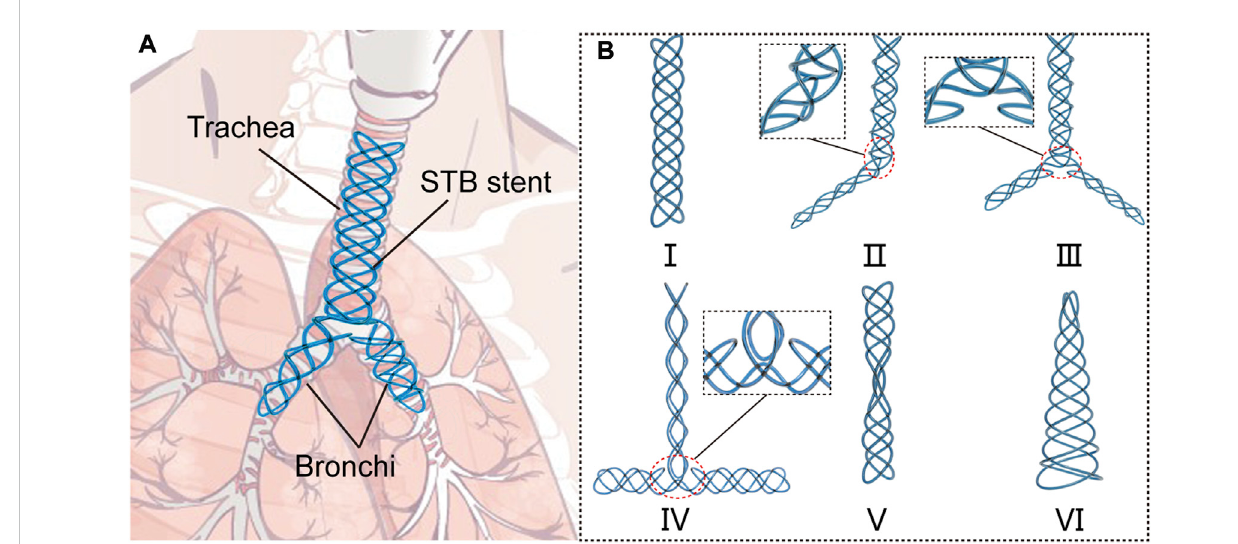
FIGURE 1 Concept of the single-tube-braided airway stent. (A) A schematic diagram, in which a Y-type single-tube-braided (STB) stent is implanted into the trachea and bronchi. (B) 6 types of STB stents for various airway structures: Type Ⅰ stent, a straight stent for central airway obstruction. Type Ⅱ stent, a L-shape stent to support trachea and one main bronchus. Type Ⅲ stent, a Y-shape stent to support trachea and both main bronchi. Type Ⅳ stent, a T-shape stent for tracheal intubation procedures. Type Ⅴ stent, an hourglass stent for tracheostenosis. Type Ⅵ stent, aconical stent for thedisorder at the end of the